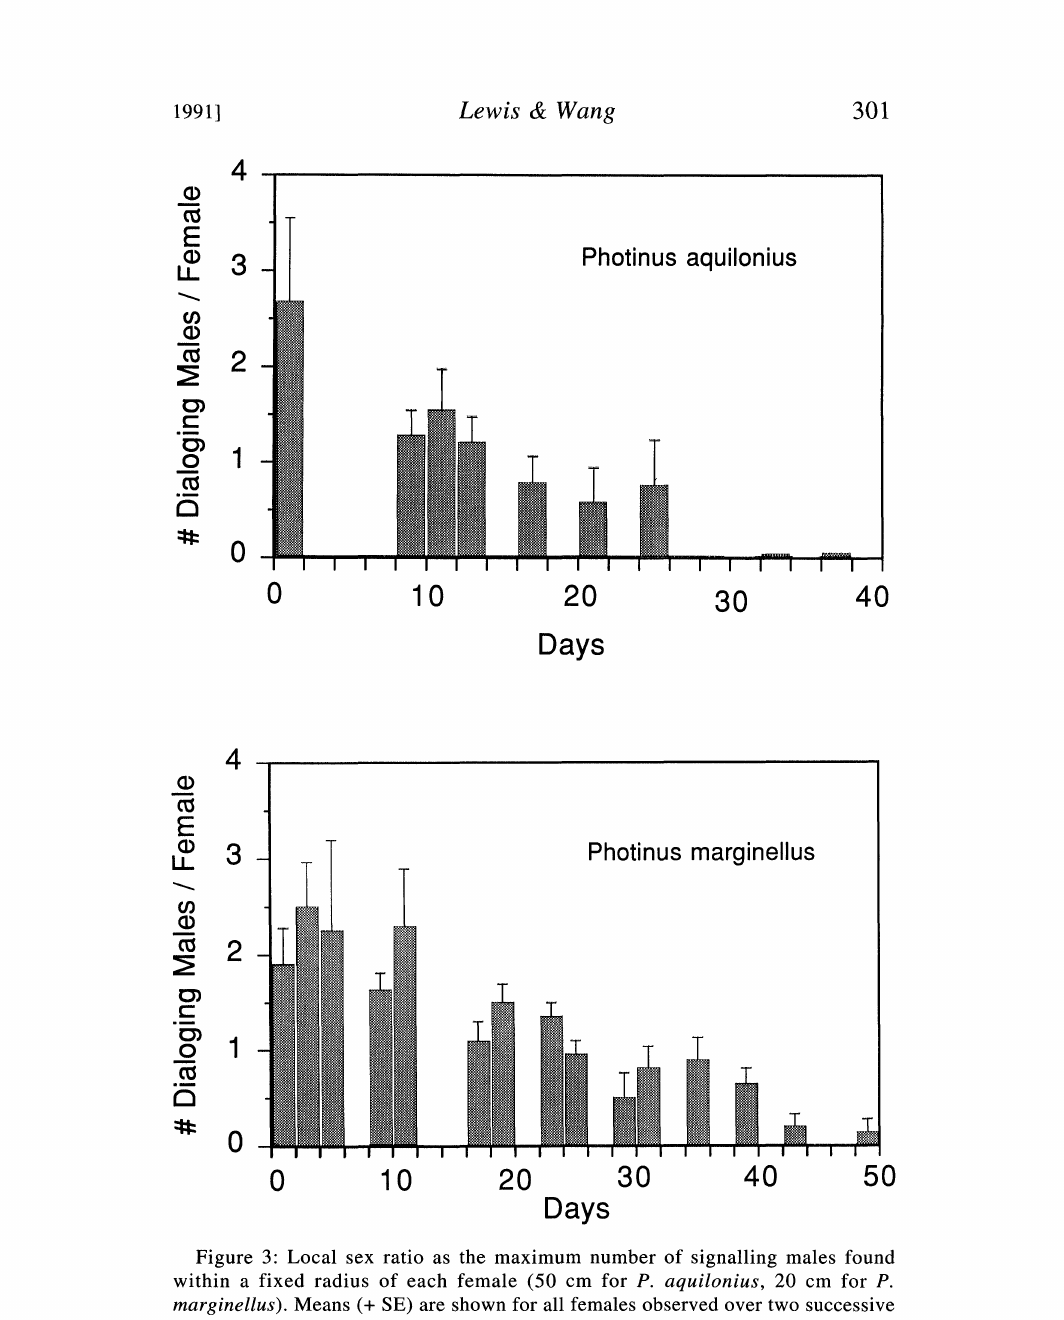
Figure 3: Local sex ratio as the maximum number of signalling males found within a fixed radius of each female (50 cm for P. aquilonius, 20 cm for P. marginellus). Means (+ SE) are shown for all females observed over two successive nights (n ranges from 7-34 females for each time